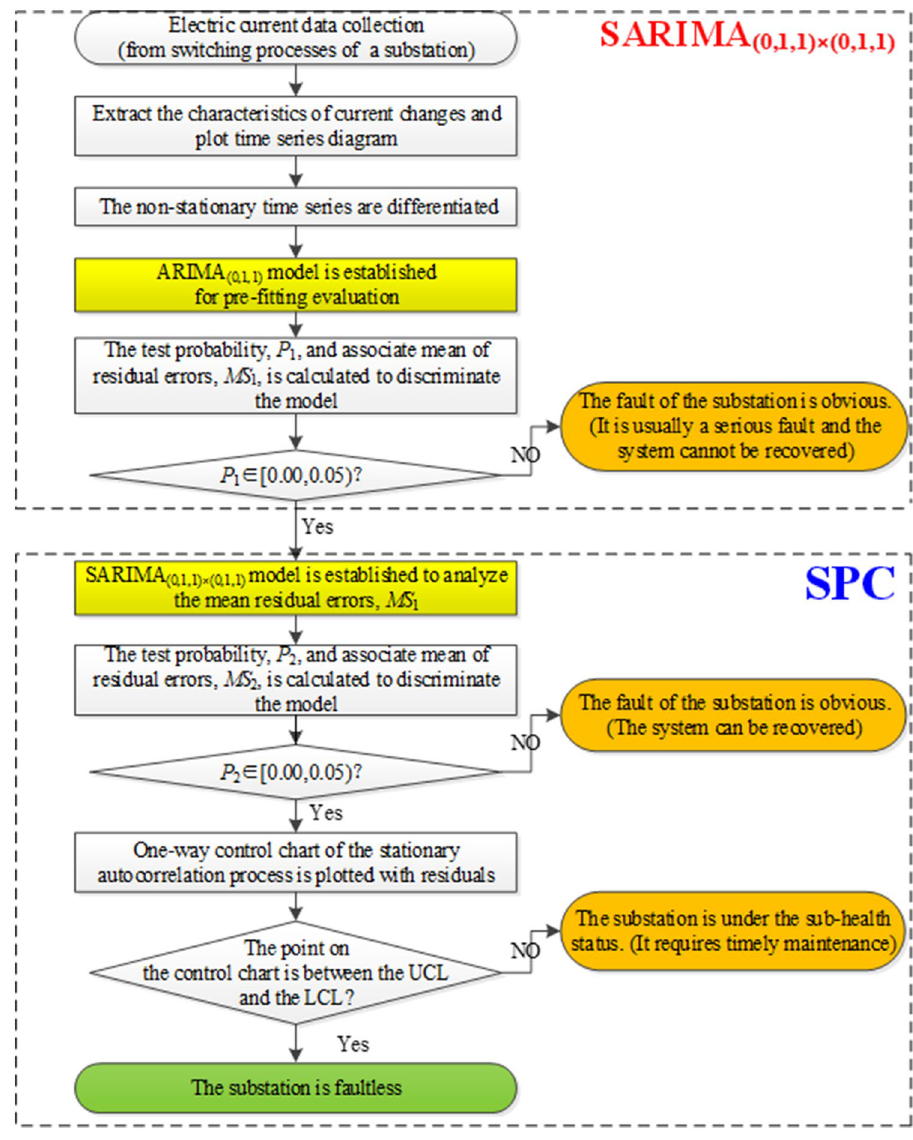
Figure 8. The flow chart of the proposed SARIMA-SPC